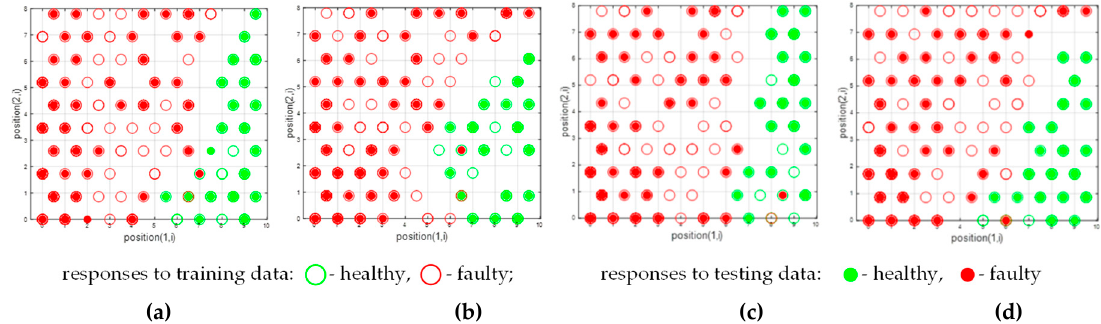
Figure 13. General schematic diagram of the self-organizing map (SOM).